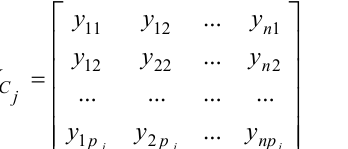
Table 1. Linguistic terms used by the decision matrix